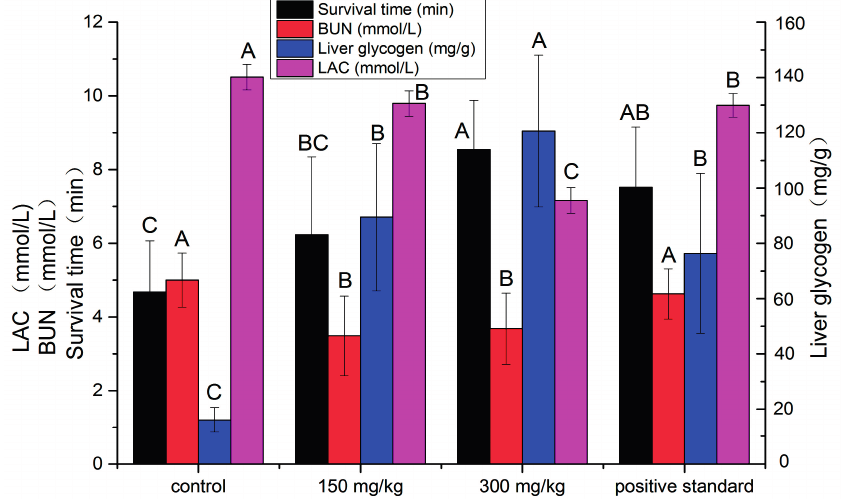
Figure 5. Effects of polysaccharide on survival time, blood urea nitrogen (BUN), liver glycogen and lactic acid (LAC) on mice. Means with different letters indicate significant differences at p < 0.05 according to DMRT. BUN: blood urea nitrogen; LAC: lactic